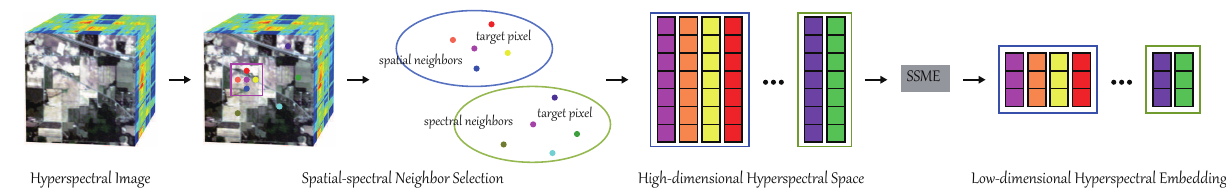
Figure 1. An illustration for the holistic workflow of the proposed SSME